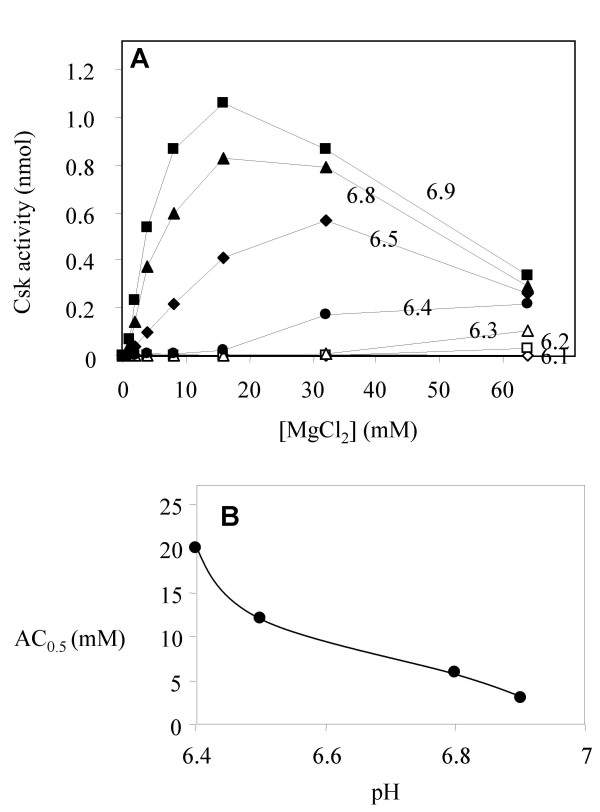
Mg2+ activation of Csk as a function of pH. (A) Mg2+ activation of Csk is determined at different pH. The pH values are labeled in the graph. (B) Plot of AC50 as a function of pH.